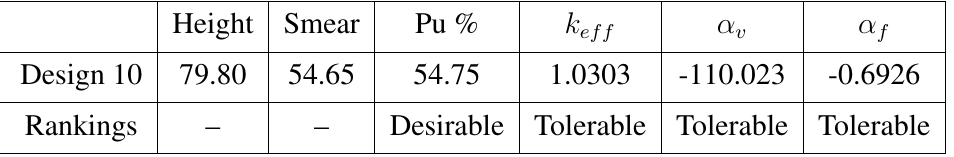
Table 7: Design for SOGA using Physical Programming